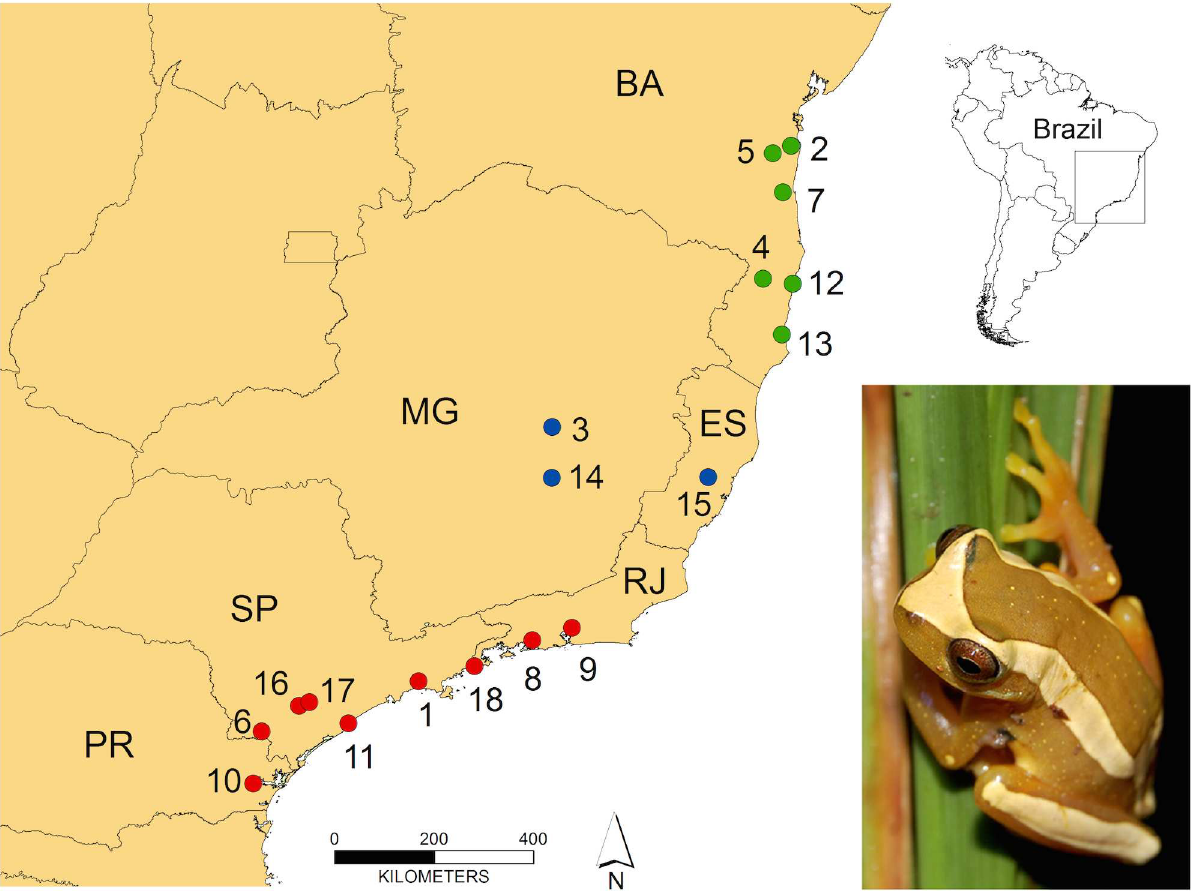
Fig 1. Sampling locations of Dendropsophus elegans . The colors of the dots correspond to each individual’sphylogeographicalclade (as in [26]): northern(green), central (blue), and southern (red). The locationnumbersare provided in S1